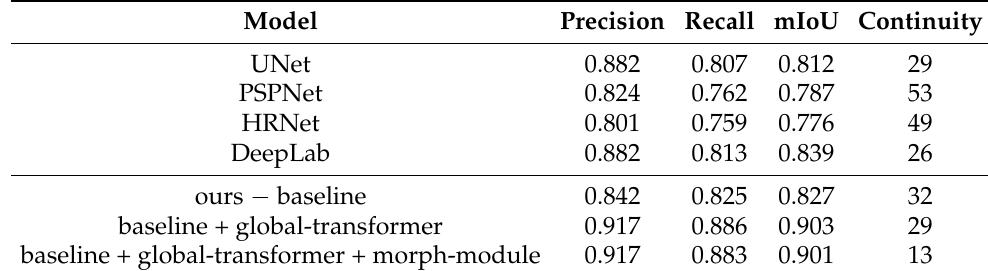
Table 7. Segmentation results of our